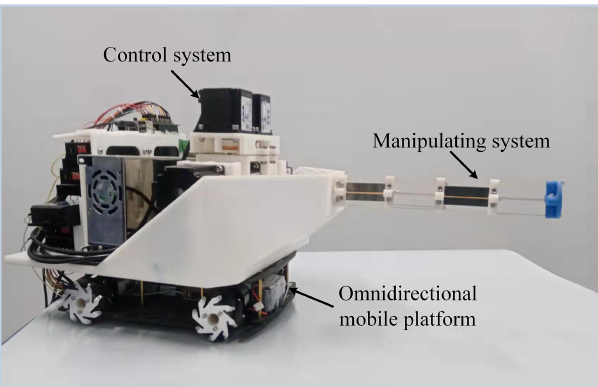
Figure 2. Prototype of cable-driven cruciform continuum robot.